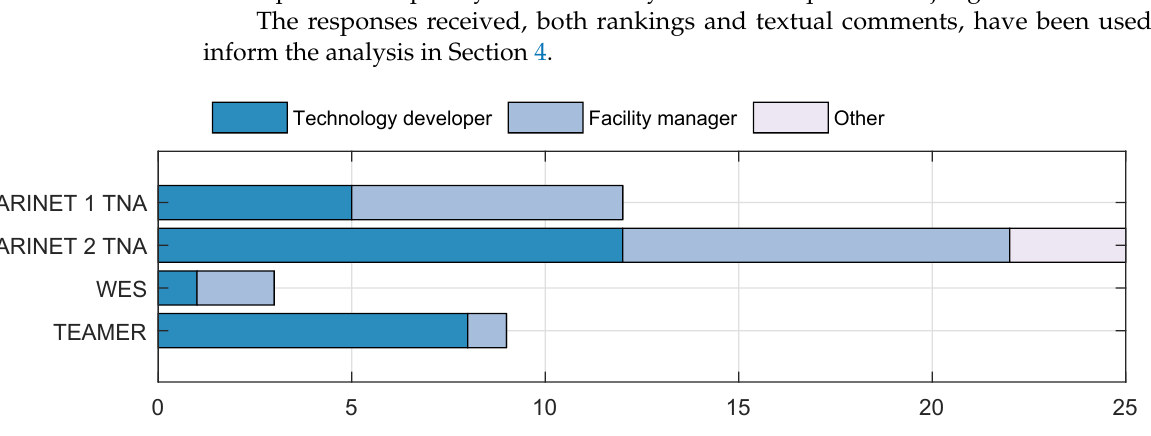
Figure 1. Breakdown of respondents by type and programme(s) they have participated in.